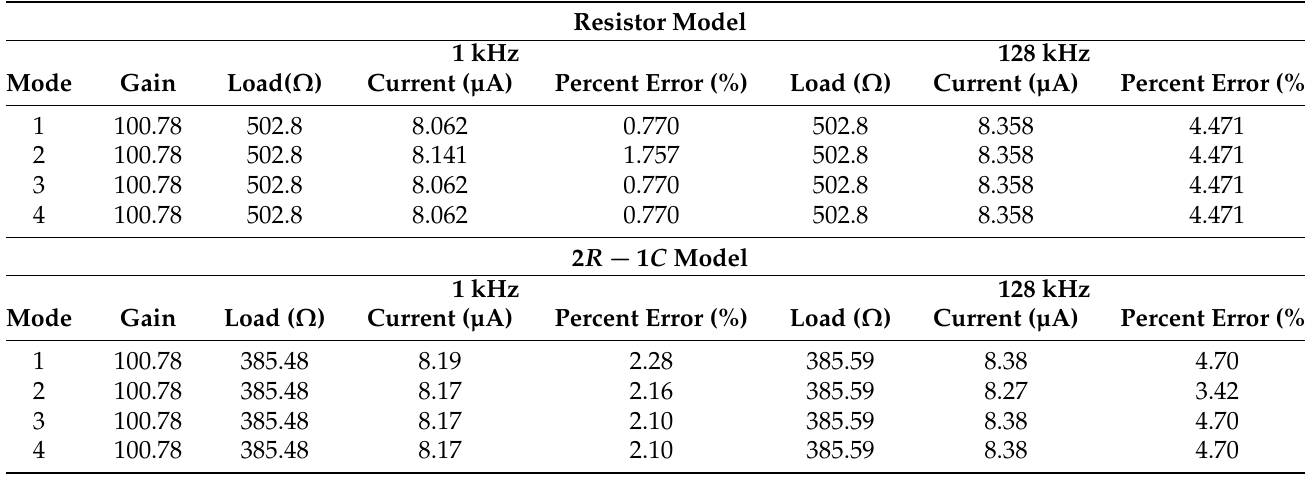
Table 5. Measured stimulus current modes of the MAX30001. Mode 1: unchopped w/ LPF, Mode 2: chopped w/o LPF, Mode 3: chopped w/LPF, and Mode 4: chopped w/ resistive